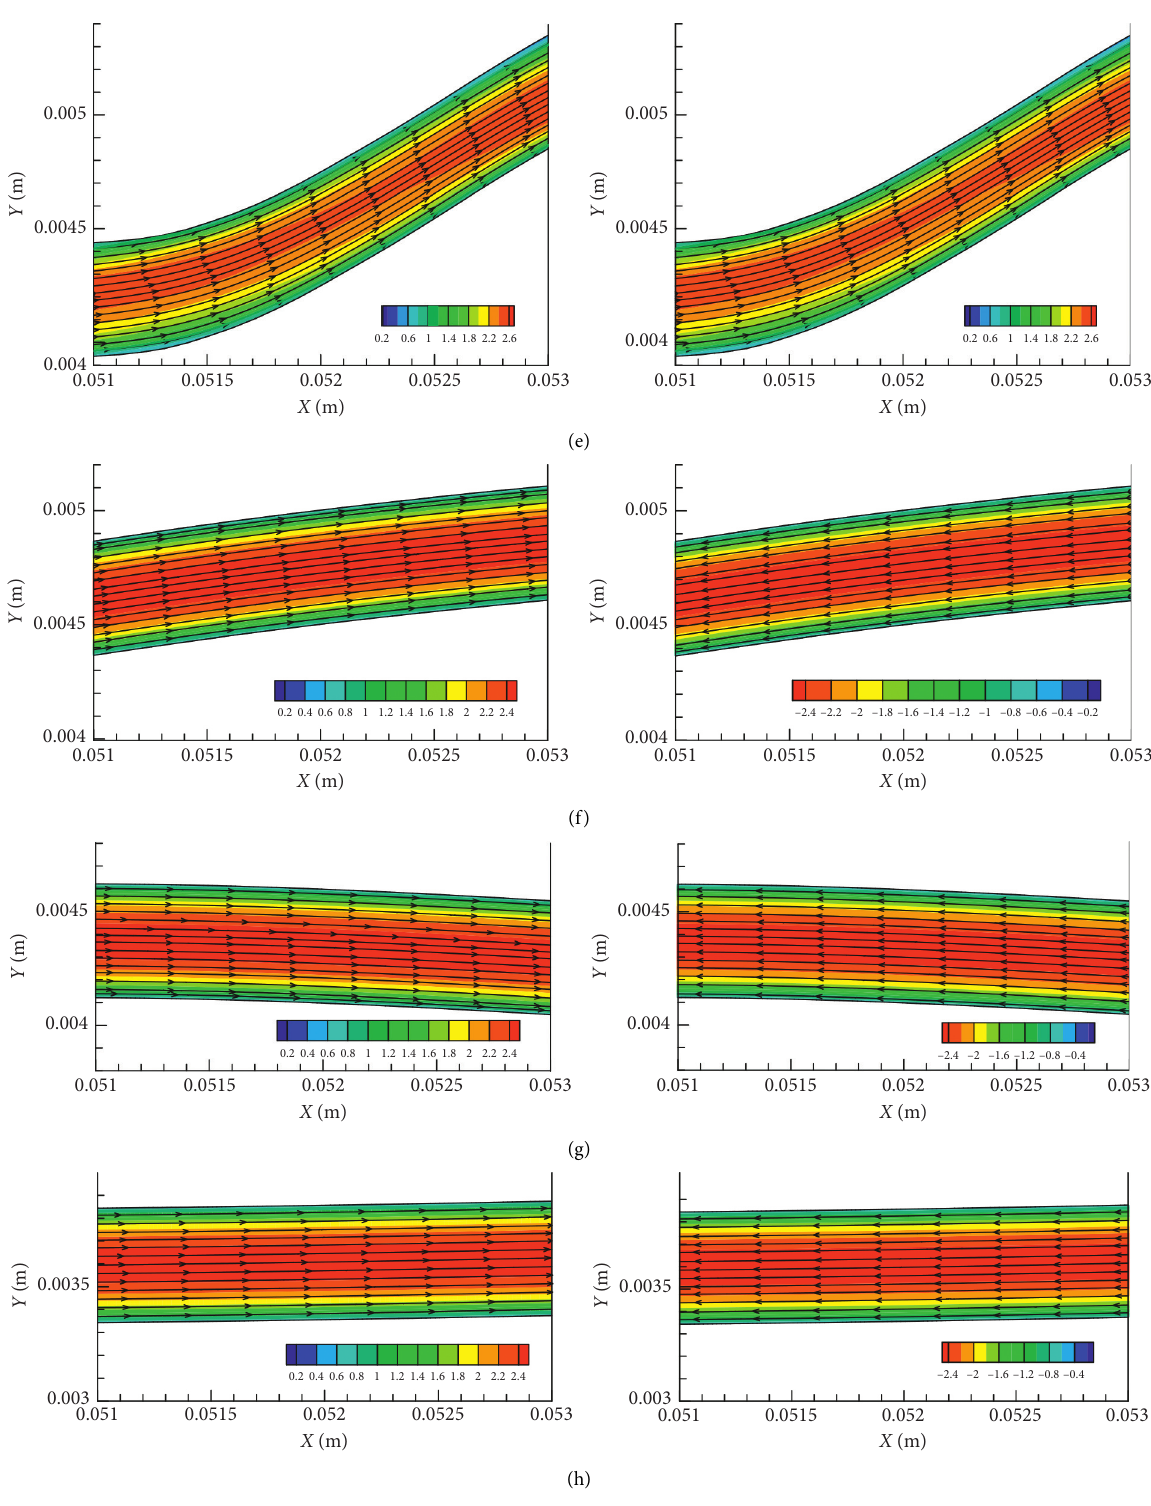
Figure 9: X -direction velocity and flow line of two directions in the approximate models when Re � 1000 (the contour represents the velocity distribution, m/s). (a) Level 1. (b) Level 2. (c) Level 3. (d) Level 4. (e) Level 5. (f) Level 6. (g) Level 7. (h) Level